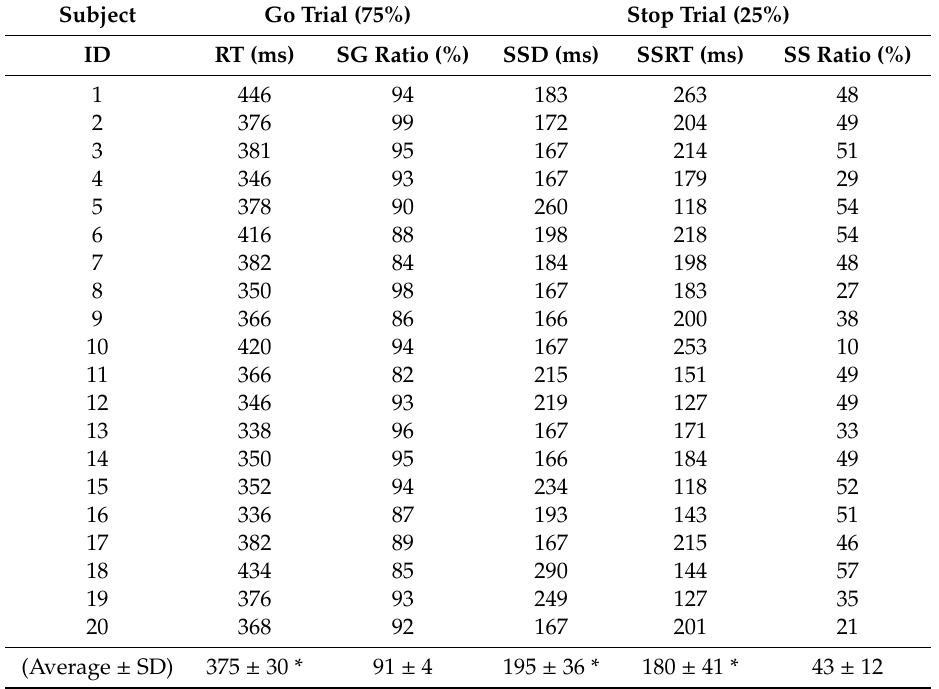
Table 1. Behavioral results during go trial and stop trial with inter-subject and intra-subject variability. Standard deviation (SD). Asterisks show the significant di ff erence in one-way ANOVA between the reaction time (RT), stop signal delay (SSD), and stop signal reaction time (SSRT) (F (2, 57) = 167.5, p <